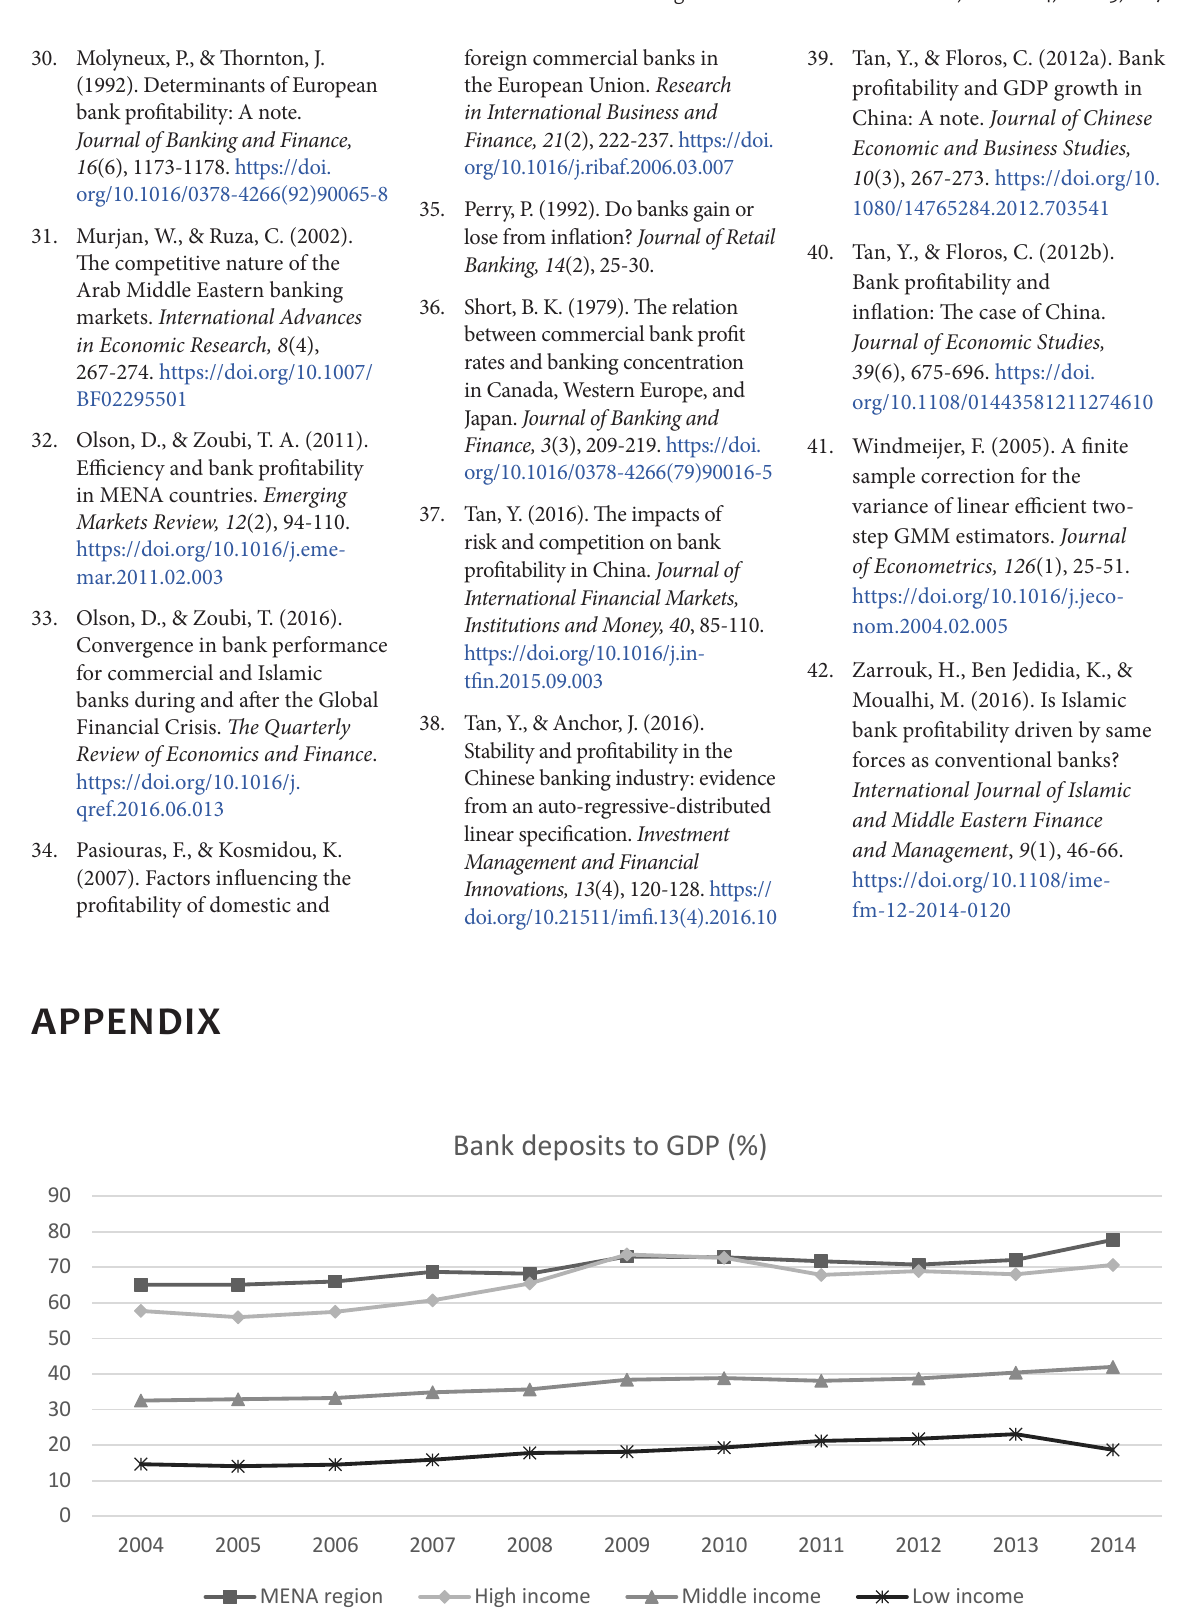
Figure 1a. Bank deposits to GDP for the MENA region over the period